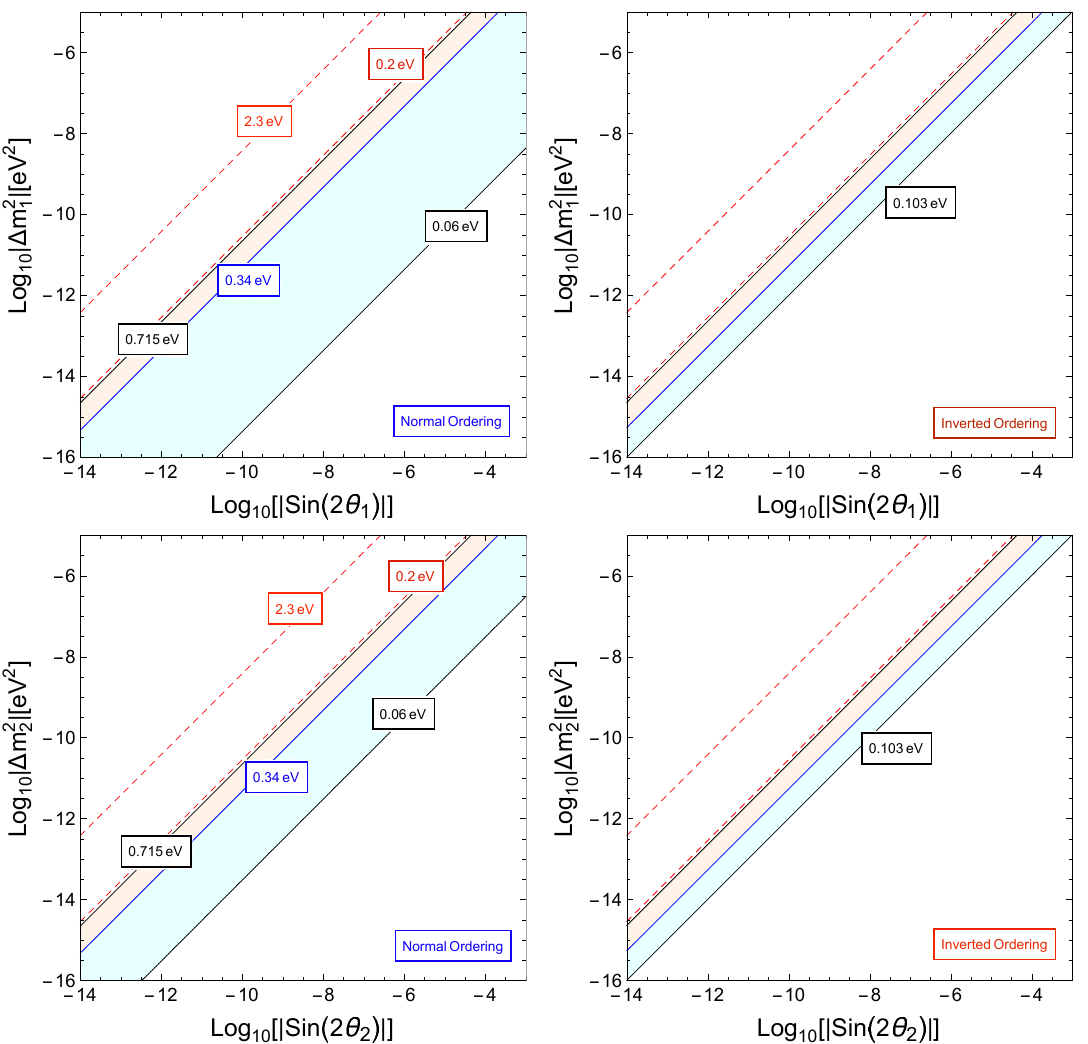
Figure 1 . Contour plots in the parameter space ( ∆ m 2 lower panel) for fixed values of P lines). The upper red-dotted line corresponds to the upper bound m ¯ ν lower red-dotted line to a future sensitivity of m ¯ ν from eq. (3.9). And the best-fit values in table-1 for the active neutrino oscillations are